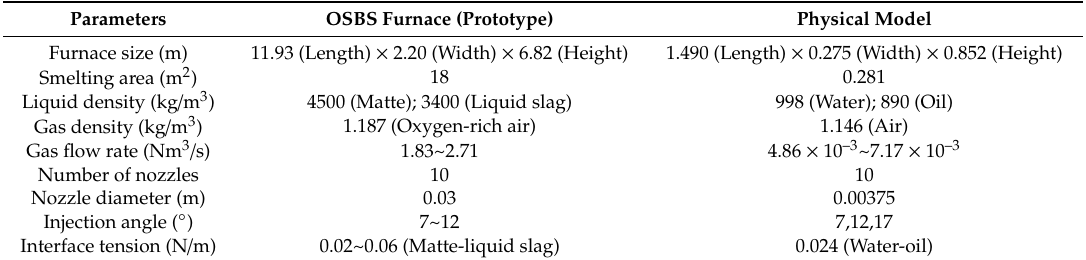
Table 1. Dimensions and main parameters of the OSBS furnace and physical